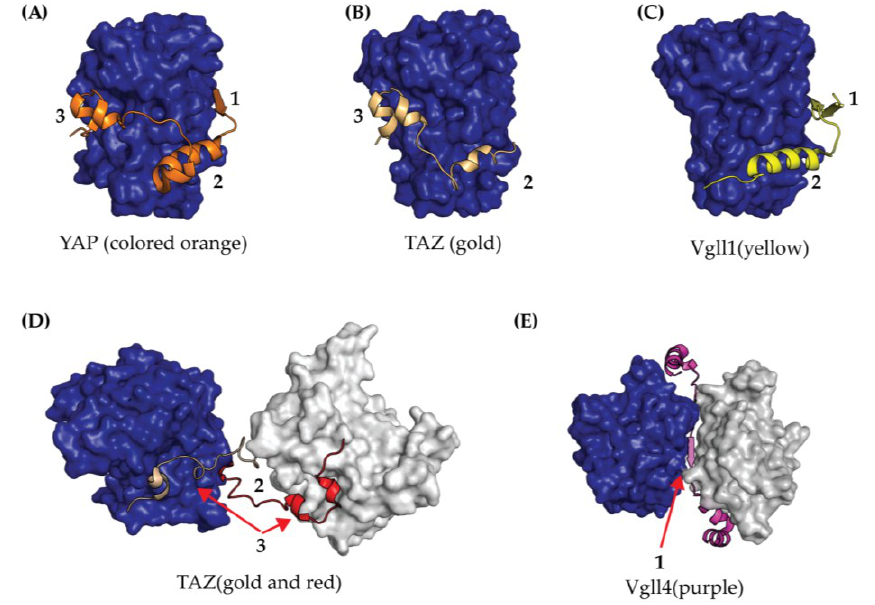
Figure 4. Crystal Structures of TEAD YBD (colored blue) bound to co-activator peptides from ( A ) YAP (orange); ( B ) TAZ binding mode one (gold); ( C ) Vgll1 (yellow); ( D ) TAZ binding mode two (gold and red); and ( E ) Vgll4 (purple). In both ( D ) and ( E ), the YBD is shown in blue and grey surface renderings since co-activators in the crystal structure induced dimerization. The TEAD binding interfaces for each co-crystal structure are labeled as 1, 2, and